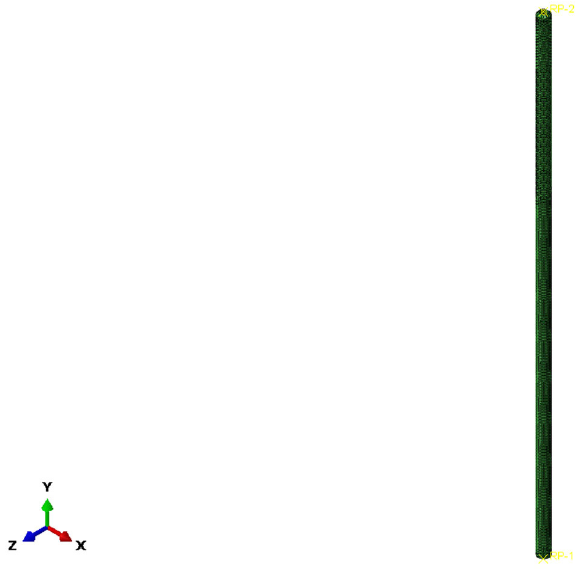
Fig. 5 Buckling test simulation of the